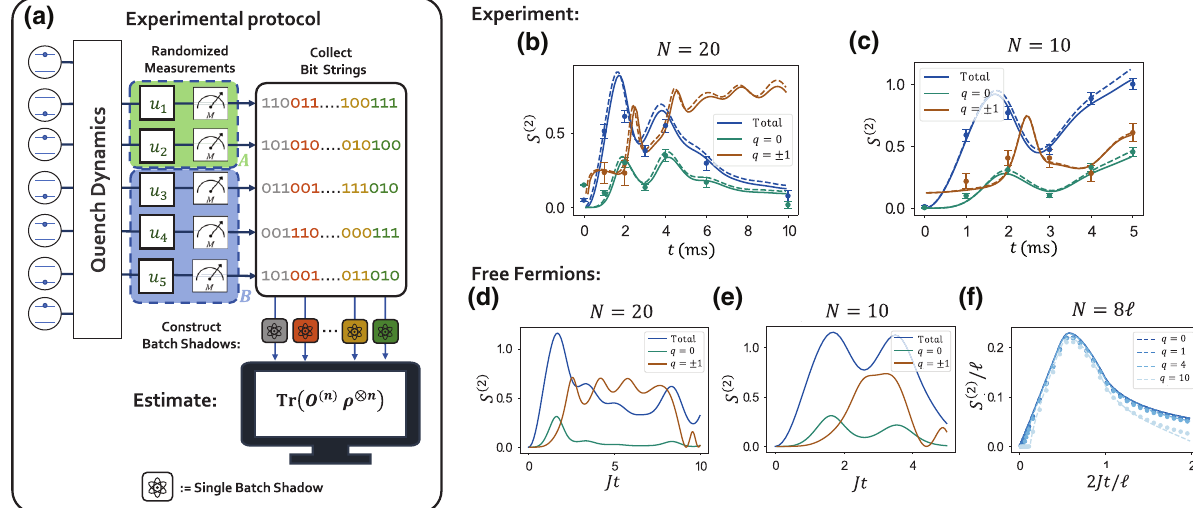
FIG. 1. An overview of the results. (a) A schematic of the method to postprocess the experimental data. After the quench dynamics, randomized measurements are performed. The collected bit strings are grouped to construct batch shadows that provide estimates of OE and SROE. (b),(c) Experimental results for the Rényi 2-OE [Eq. (4)] and its symmetry resolution [Eq. (14)] of a reduced density matrix formed from a partition of (b) 4 ions out of 20 and (c) 10 ions from the data of Ref. [7] after the global quantum quench. The points correspond to the experimental data, while the curves are numerical results obtained via tensor-network algorithms with (solid) or without (dashed) dissipation considered. The entanglement barrier is visible for the total OE and the symmetry sector q = 0 with N = 20. (d)–(f) Symmetry resolution of the OE of the reduced density matrix after a global quantum quench in a free- fermion chain under unitary evolution. (d),(e) Symmetry resolution of the OE of the reduced density matrix after a global quantum quench, for a 4 out of 20 (out of 10) sites chain. Comparing with the experimental results in (b) and (c), respectively, we can spot several qualitative features of OE even though the model is short ranged and there is no dissipation. (f) Numerical data (circles) with subsystem length (cid:5) = 256, (cid:5) A = (cid:5) − (cid:5) B = 120 compared with the quasiparticle prediction of Eq. (46) (continuous lines). This plot shows the three main features of SROE in the thermodynamic limit, i.e., the barrier in each sector q , the time delay, and the equipartition for small q . In the free-fermion plots, J is the hopping term and we consider, for the sake of simplicity, (cid:2) = 1 and lattice constant a =